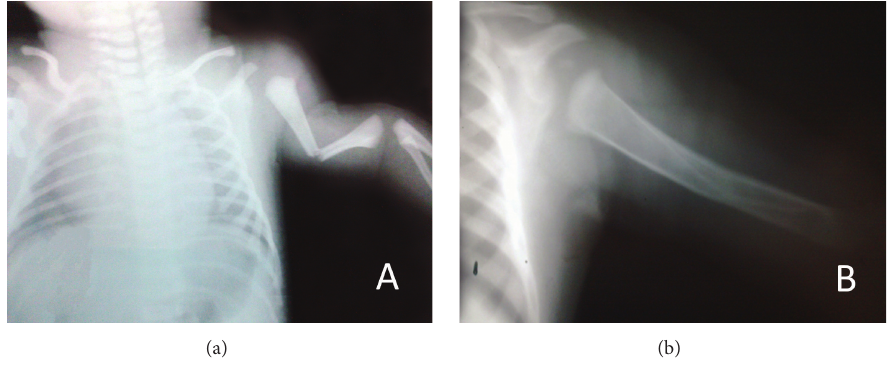
Figure 1: (a) Radiograph of fractured humerus prior to reduction and immobilization. (b) After 2